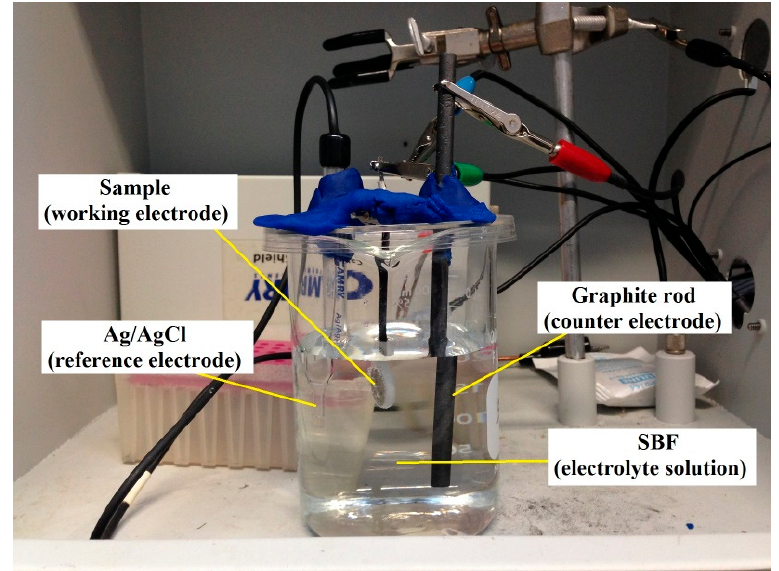
Figure 4. The electrochemical cell unit used for determining the electrochemical characteristics of the prepared samples.